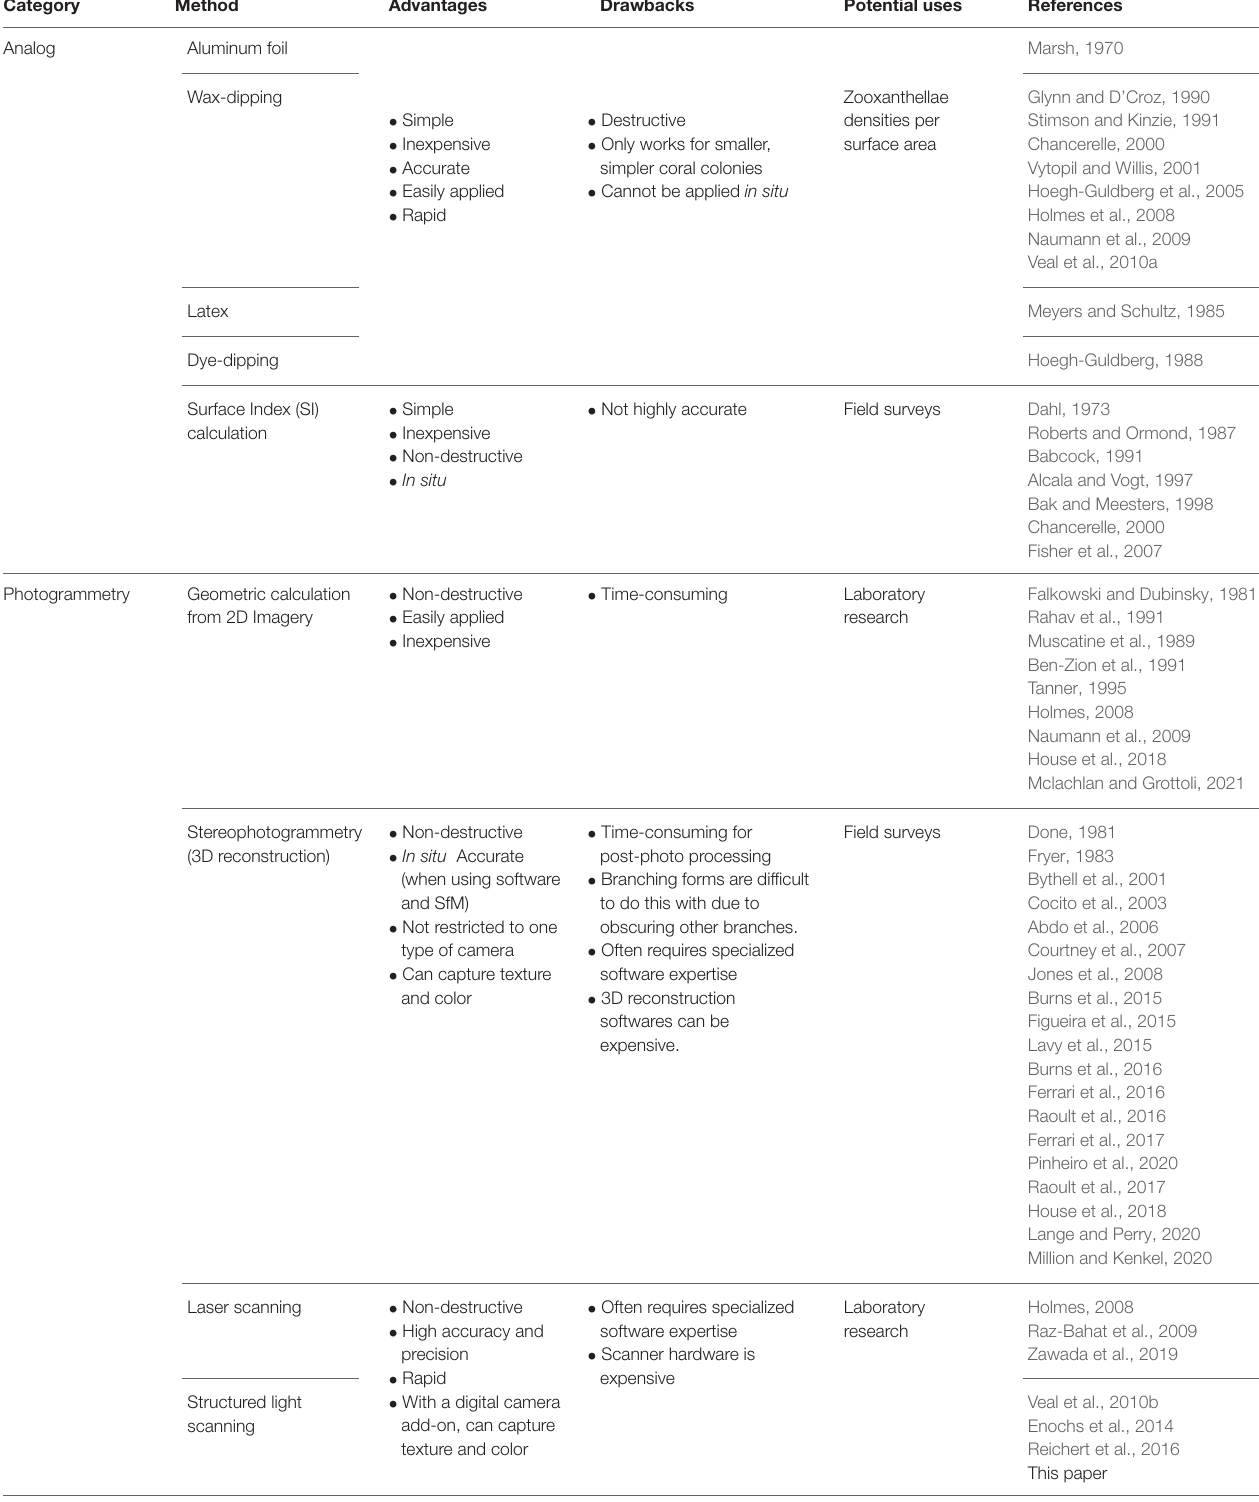
TABLE 1 | A non-exhaustive list of methods to measure surface area of coral reef sessile epibenthic organisms (e.g., corals, sponges, hydrocorals, algae).